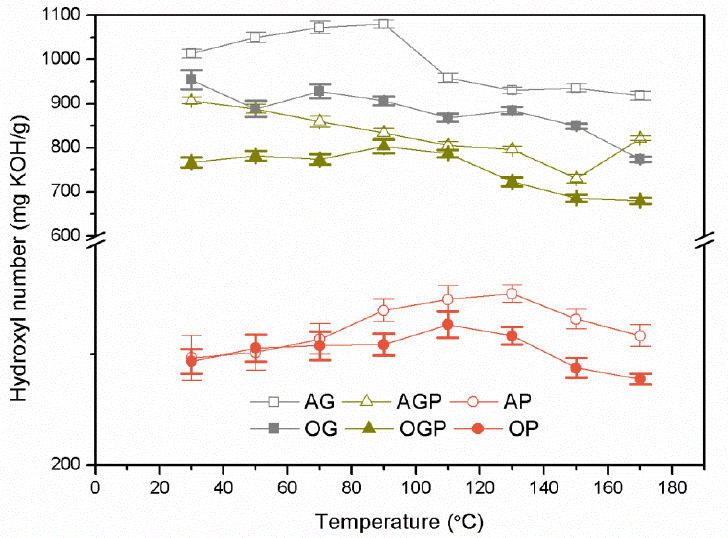
Figure 1. Changes in hydroxyl number depending on the liquefaction reaction temperature during heating.